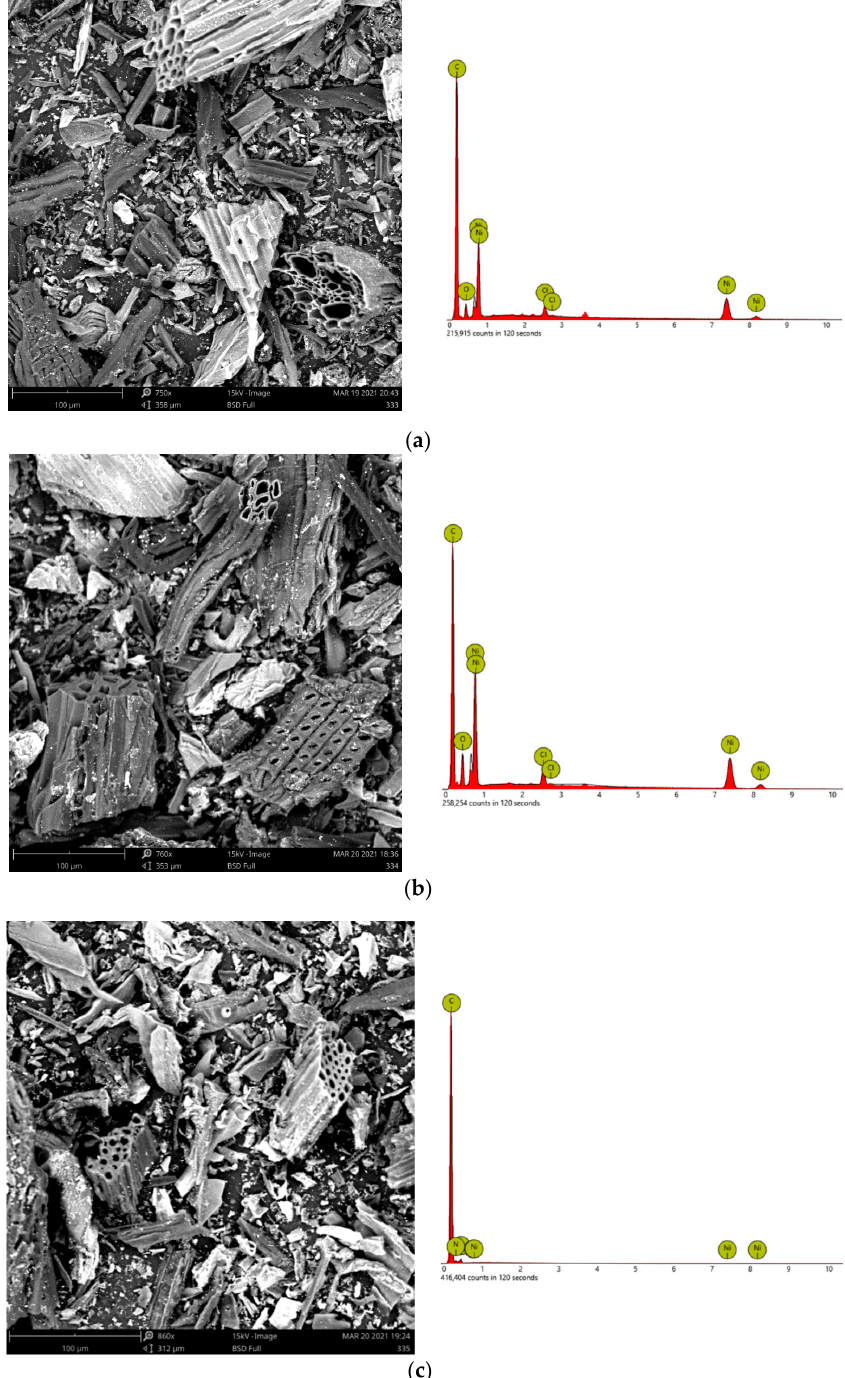
Figure 4. SEM images of synthesized NC together with data of EDS analysis of the basic substance: